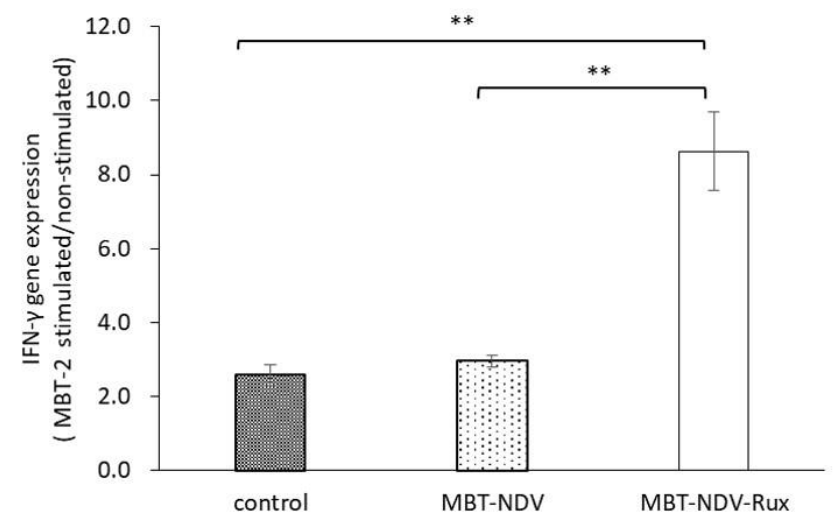
Figure 6. IFN- γ gene expression in MBT-2 stimulated SMCs. SMCs from immunized mice were co-cultured with MBT-2 for 4 h. Then, IFN- γ gene expression of the SMCs were analyzed by qPCR. The gene expression was normalized with glyceraldehyde-3-phosphate dehydrogenase (GAPDH), and the comparison of gene expression upon stimulation against unstimulated was calculated (** p < 0.01, each group n = 5).